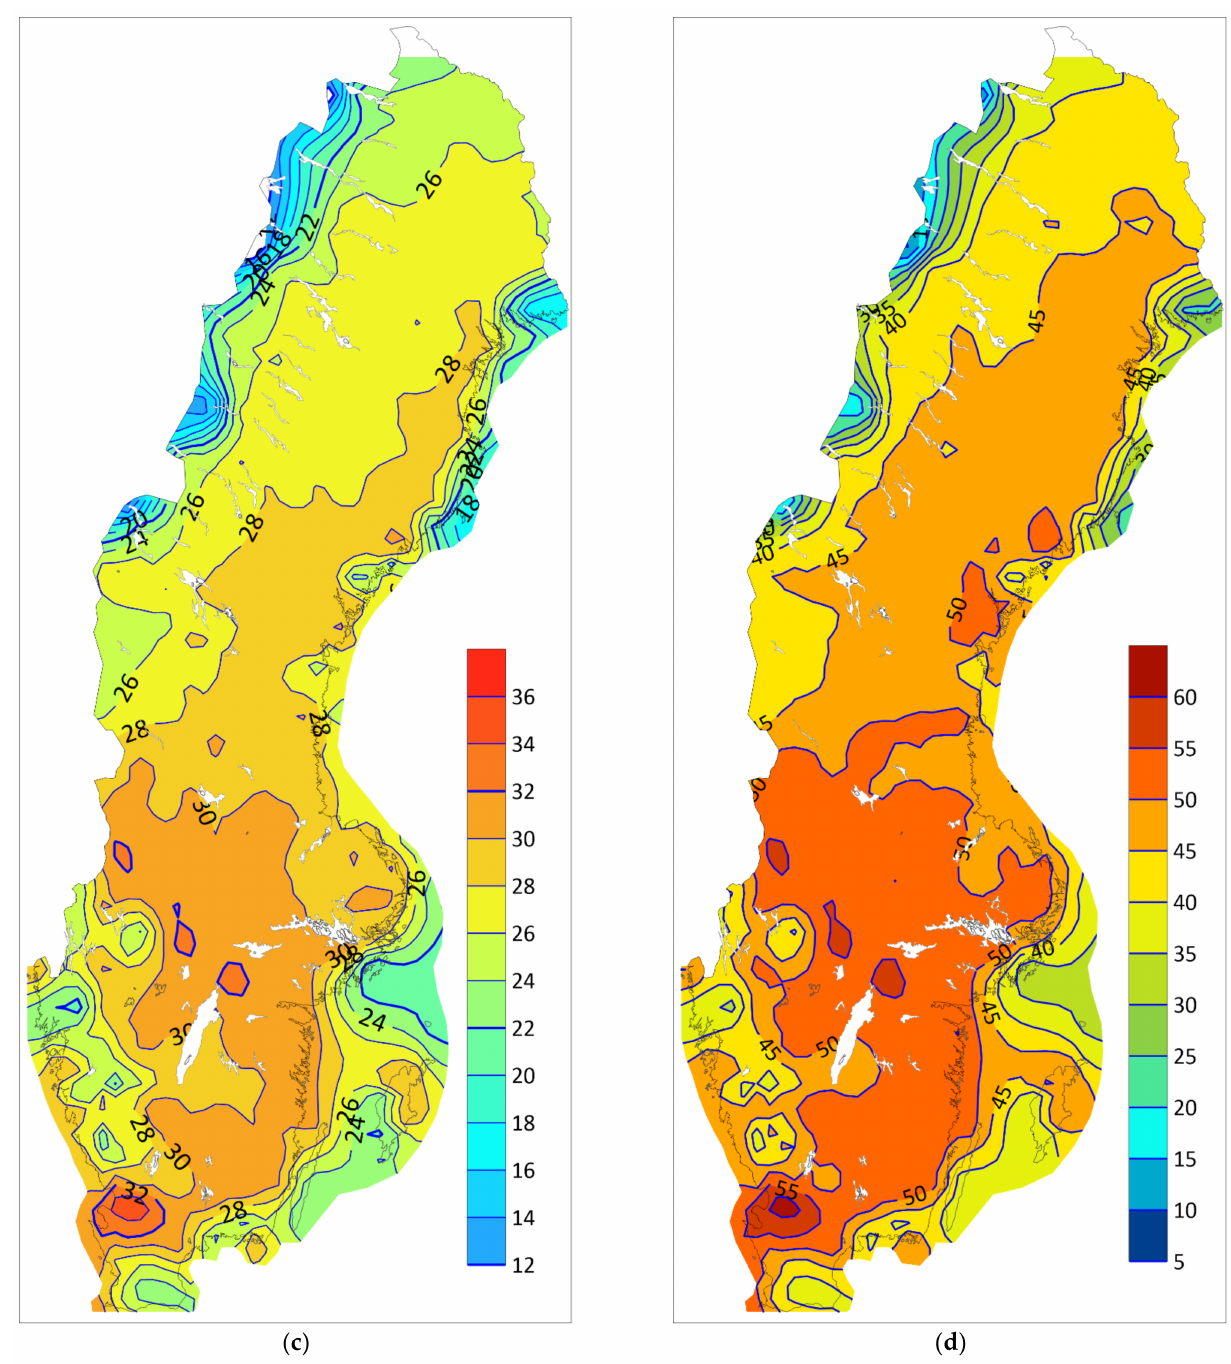
Figure 8. ( a , b ) IDF maps of Sweden based on the formula R . Map 8a illustrates the rainfall pattern with 10 min of duration and 10 years of recurrence. Map 8b illustrates 10 min of duration with 100 years of recurrence. Unit: mm. ( c , d ) IDF maps of Sweden based on the formula R . Map 8c illustrates the rainfall pattern with 60 min of duration and 10 years of recurrence. Map 8d illustrates 60 min of duration with 100 years of recurrence. Unit: